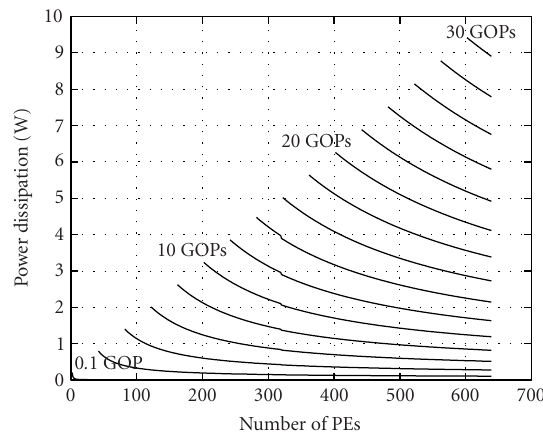
Figure 7: Impact of voltage scaling on power dissipation. Figure 8: Energy scaling factor for varying computational